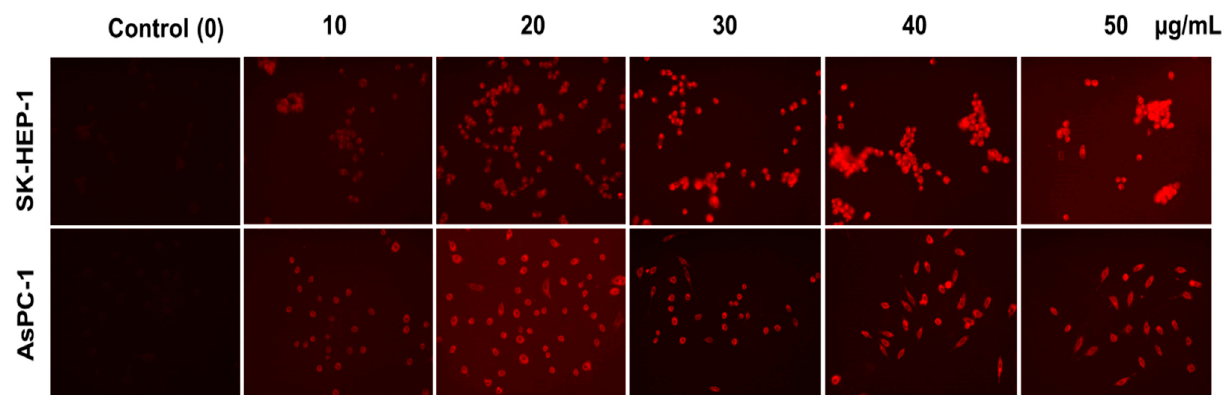
Figure 6. Cellular uptake of bay leaf extract in liver and pancreatic cancer cell lines. SK-HEP-1 (liver cancer) and AsPC-1 (pancreatic cancer) cell lines were used for uptake study. Cells were treated with different concentrations of bay leaf extract (contains chlorophyll) for 1 h and imaged using a fluorescent microscope. SK-HEP-1 cells showed higher uptake of chlorophyll. Images were taken at 100×.